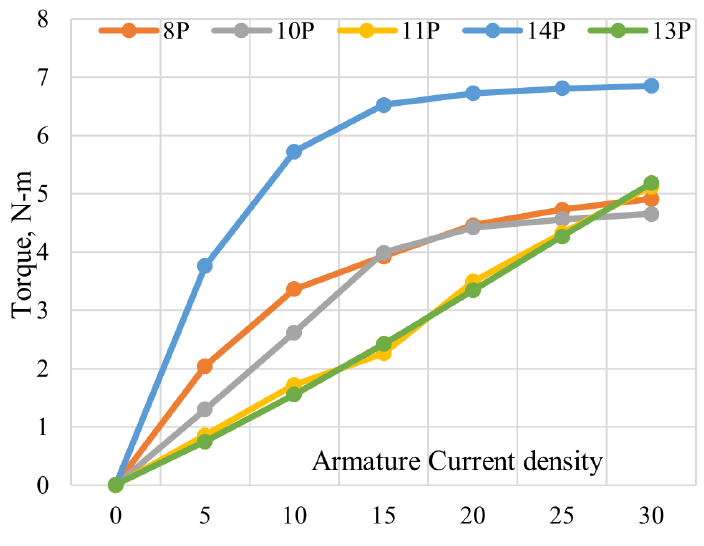
Figure 11. Average torques of different